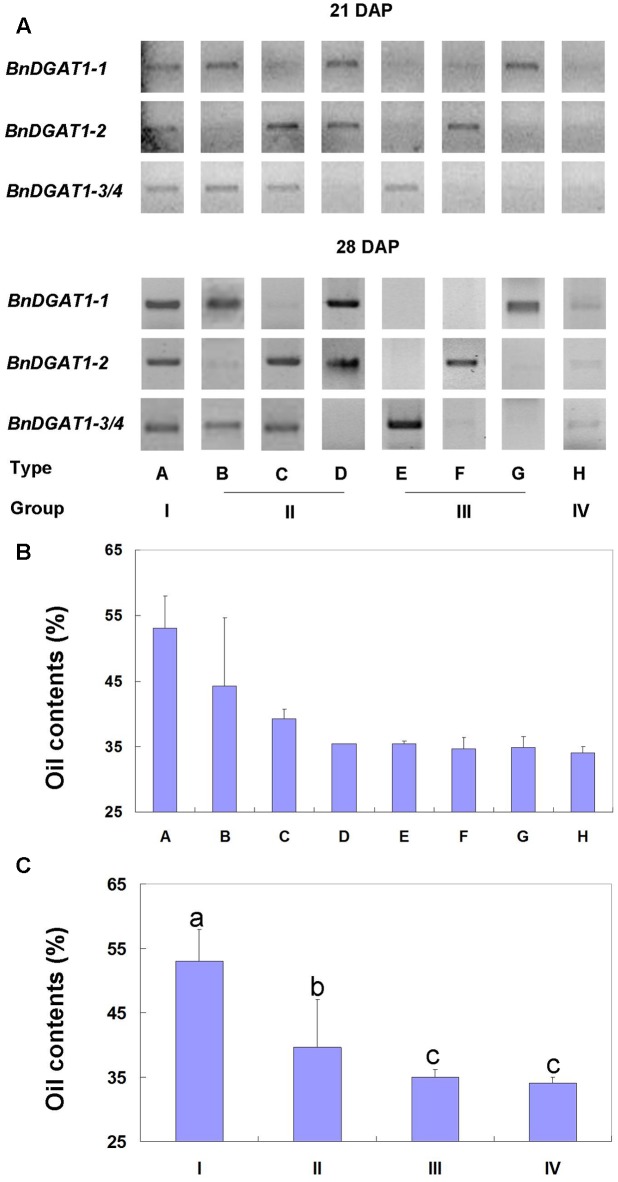
The expression patterns of BnDGAT1s and related seed oil contents in Brassica napus. (A) Expression patterns of BnDGAT1s in four groups and eight types of B. napus lines (each type chose one line as represent). Samples of developing seeds from 21 and 28 DAP stages are from same line. Primers and semi-quantitative PCR conditions are described in Section “Materials and Methods.” (B) Seed oil contents of eight types of B. napus lines. (C) Seed oil contents of four groups of B. napus lines. Error bars in B and C indicate SD of oil contents from lines in the types or groups.